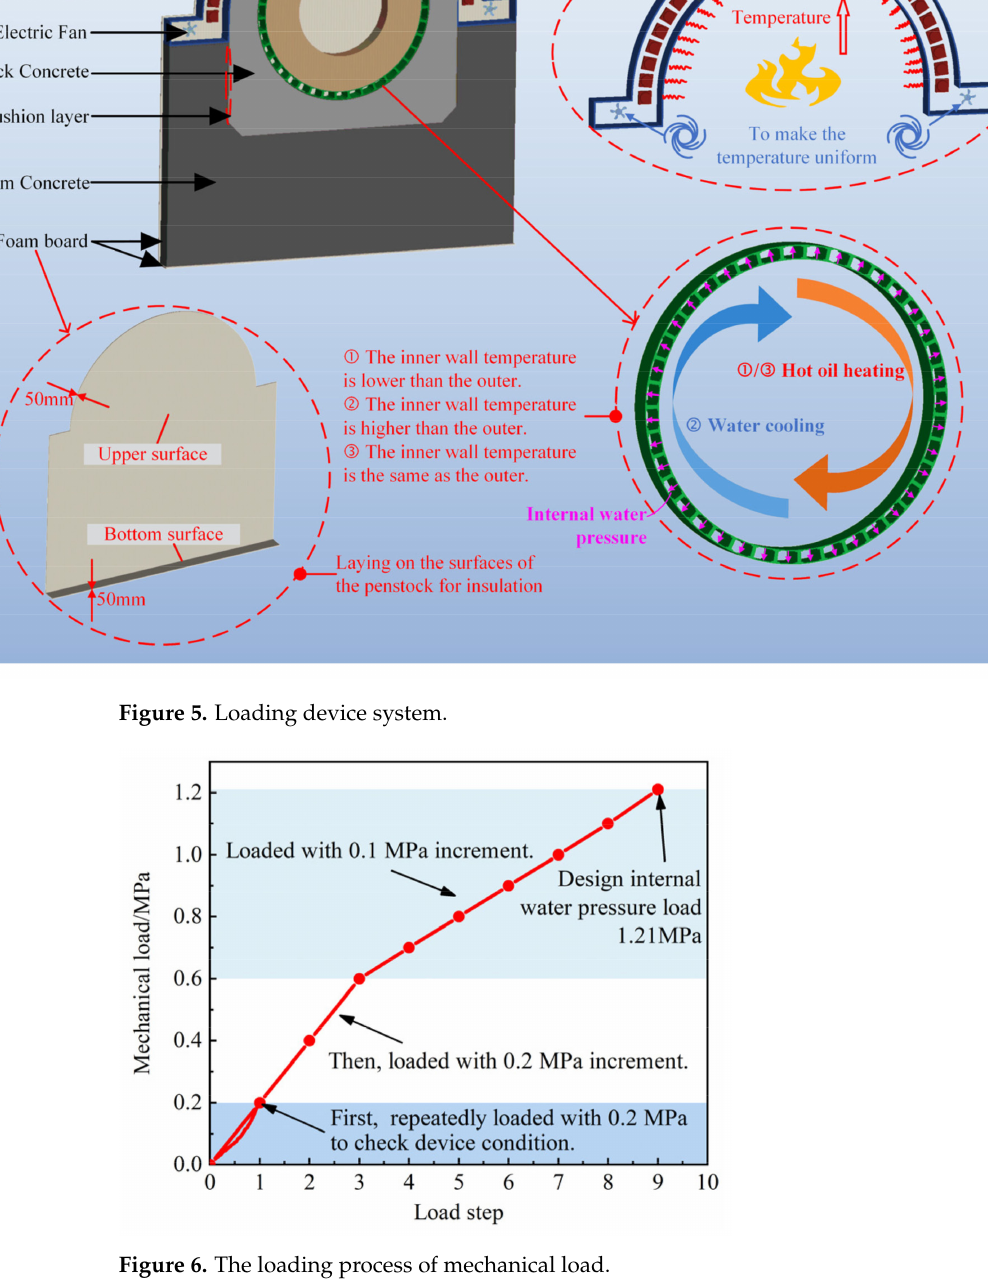
Figure 6. The loading process of mechanical